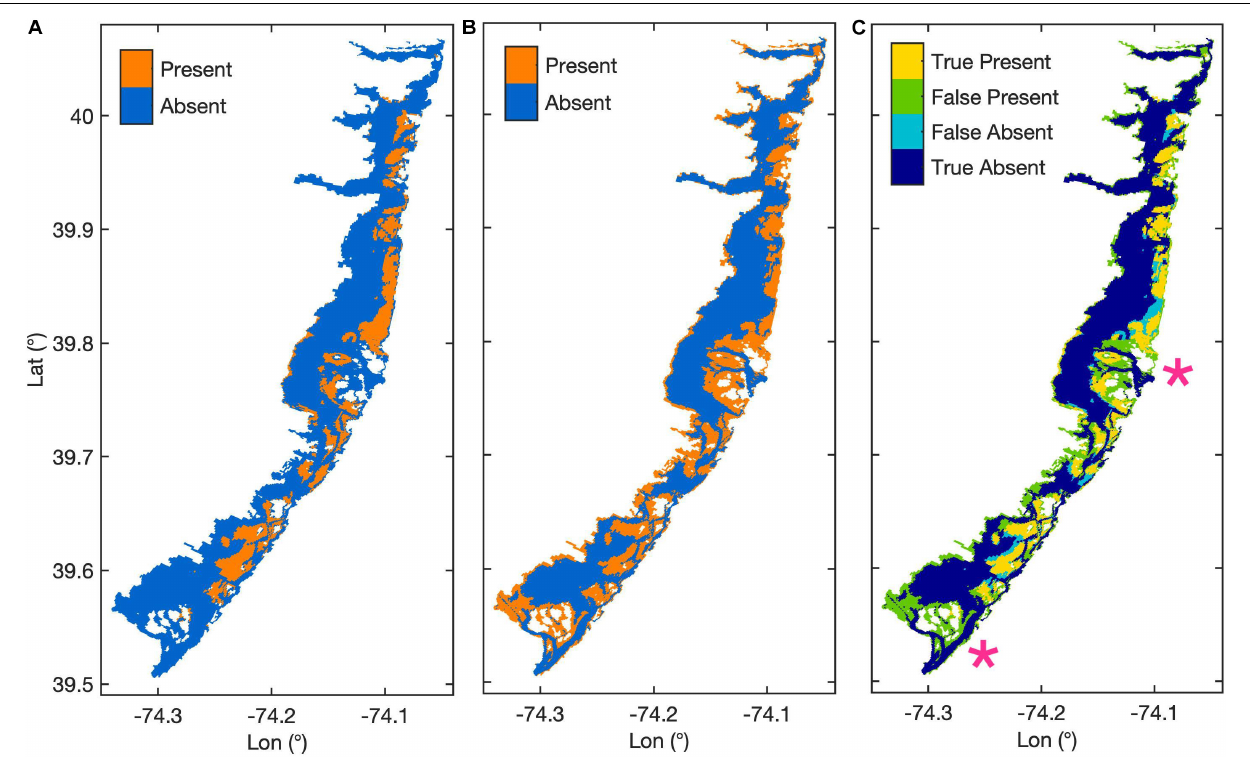
FIGURE 2 | Maps of modeled area where (A) shows mapped seagrass habitat extent in 2009 from Rutgers CRSSA (Lathrop and Haag, 2011), (B) shows the base case modeled seagrass habitat extent, and (C) shows the agreement between the modeled habitat in the base case and mapped habitat extent, with pink stars marking the central and lower